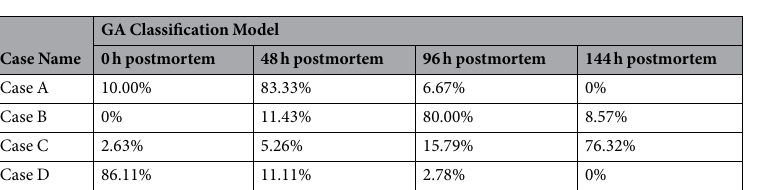
Table 6. Real routine applications of the complete GA classification model.